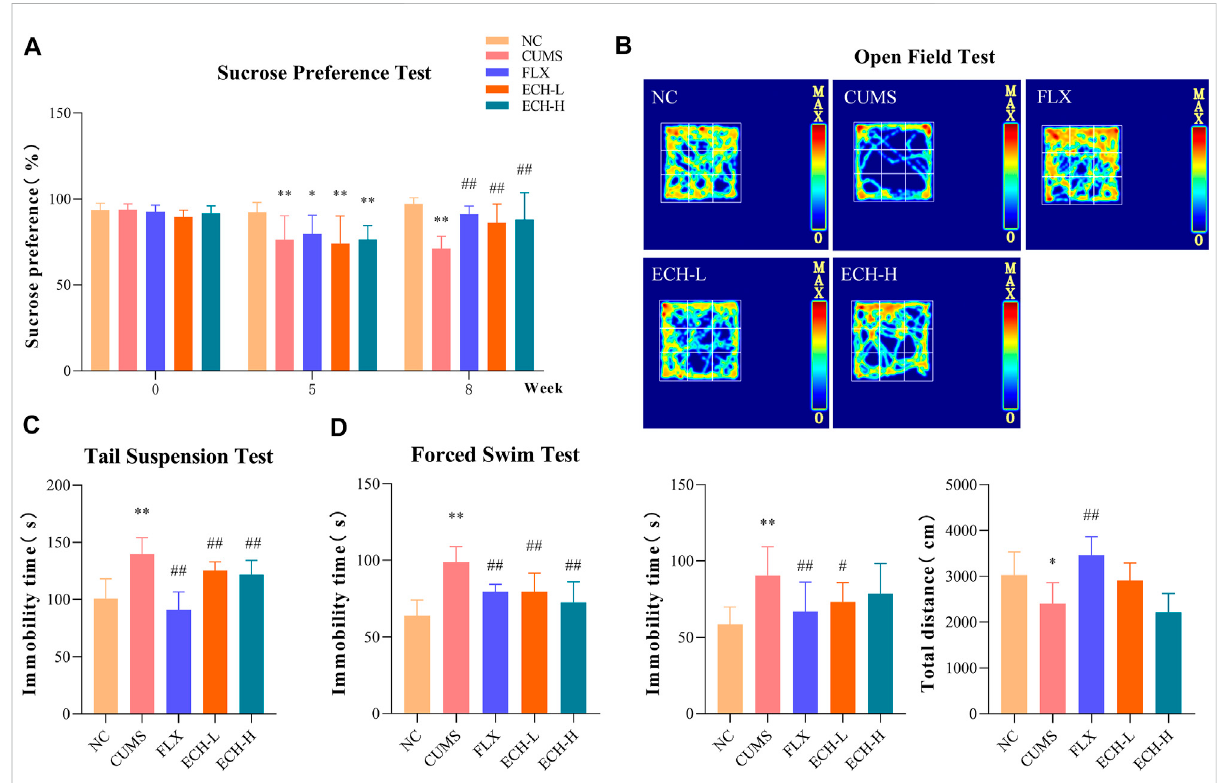
FIGURE 1 Effects of echinacoside (ECH) on chronic unpredictable mild stress (CUMS)-induced depressive-like behaviors. NC, un-treated normal mice; CUMS, mice were treated with the chronic stimulating factors for 7 weeks to set up the CUMS depression model; FLX, CUMS induced mice were administered with fl uoxetine (10 mg/kg,i.g.) daily for 21 days; ECH-L, CUMS induced mice were administered with echinacoside (15 mg/kg,i.g.) daily for 21 days; ECH-H, CUMS induced mice were administered with echinacoside (60 mg/kg,i.g.) daily for 21 days. (A) sucrose preference (%) in sucrosepreferencetest(SPT); (B) immobility time(s)andtotaldistanceinopen fi eldtest(OFT); (C) immobilitytime(s)intailsuspensiontest(TST); (D) immobility time (s) in forced swimming test (FST). n = 6/group. ** p < .01 compared with control group; # p < .05, ## p < .01 compared with CUMS